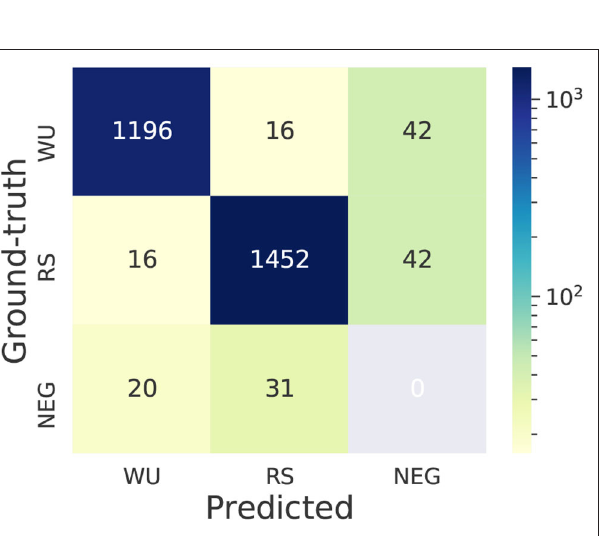
FIGURE 12 | Confusion matrix of the top system for trigger word prediction in Task 2—EE. WU: WORKUP. RS: REACTION_STEP. NEG (negative trigger word): ground-truth (or predicted) trigger words whose text spans are not annotated as trigger words in the predicted (or ground-truth) set. This confusion matrix is computed under the scenario of exact